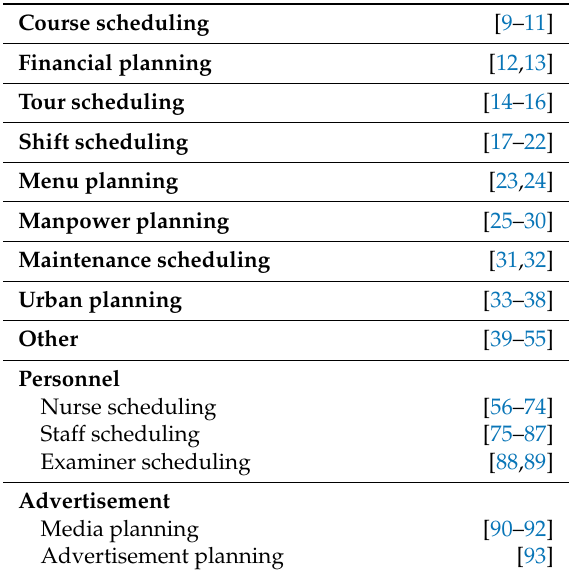
Table 1. Studies by scheduling and planning